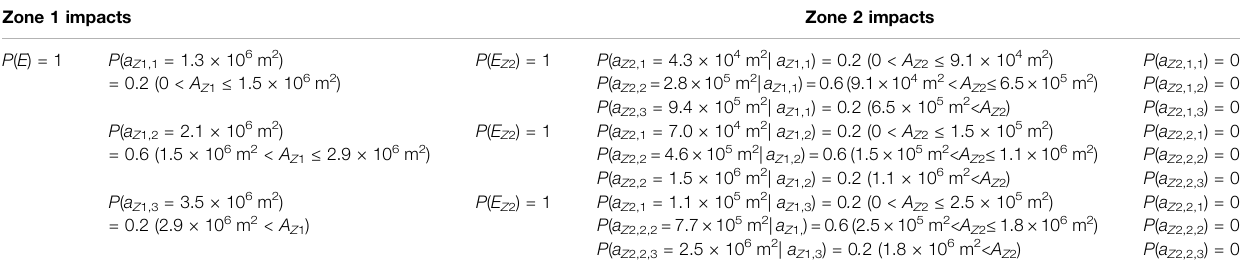
TABLE 4 | Summary of event tree calculation. Ranges of values corresponding to each representative value are given in